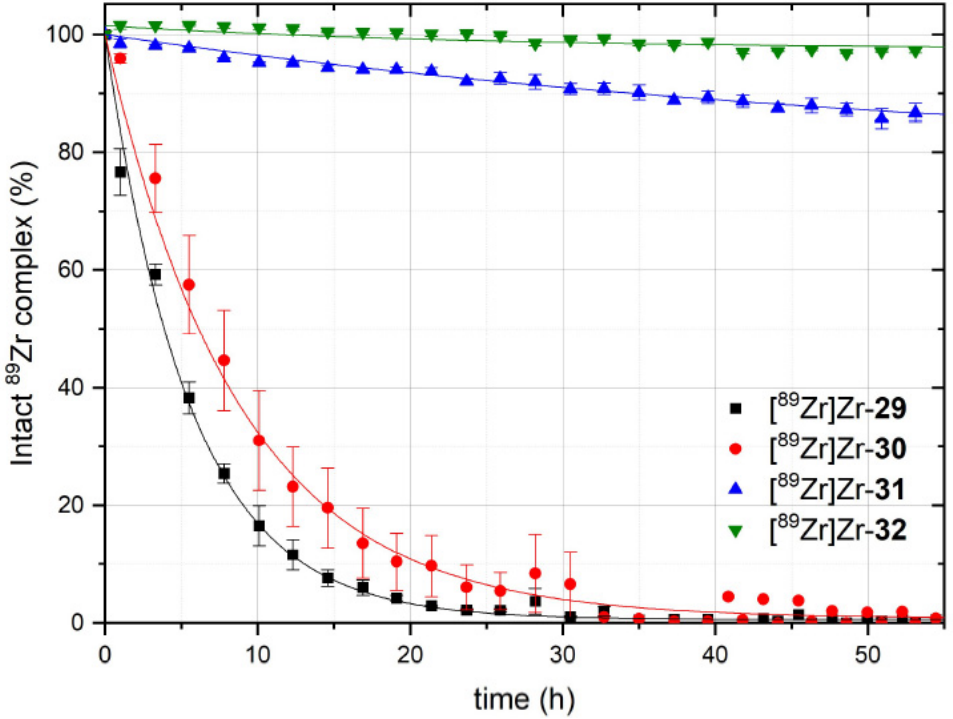
Figure 5. Summary of the results of the complex challenge experiments of [ 89 Zr]Zr- 29 –[ 89 Zr]Zr- 32 using a 10,000-fold excess of EDTA as the challenging agent. The radiochemical purity of the starting materials was normalized to 100% at the start of the EDTA challenge.